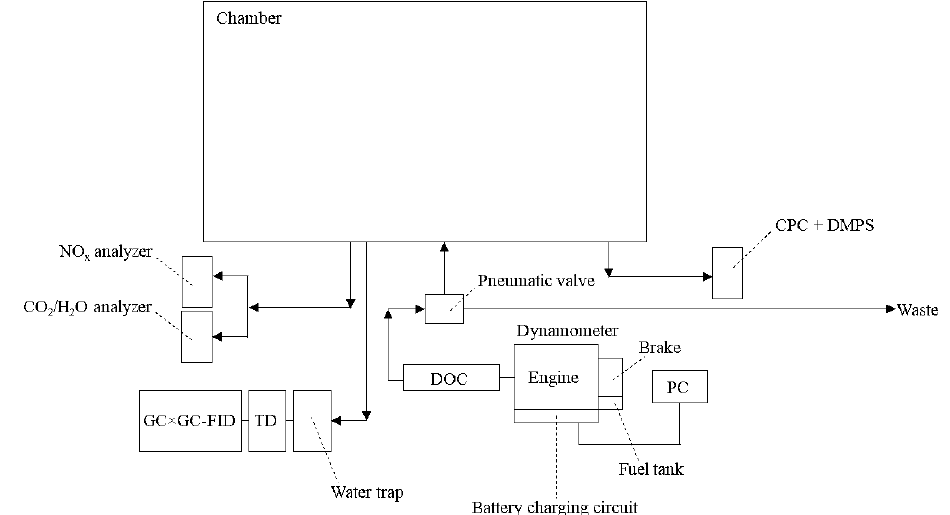
Figure 1. Schematic of dynamometer and sampling system. Arrows display air flow direction. CPC is the condensation particle counter. DMPS is the differential mobility particle sizer. DOC is the diesel oxidative catalyst. TD is the thermal desorption unit. GC × GC-FID is the comprehensive two-dimensional gas chromatography flame ionisation detector. See Sect. 2.3 for further